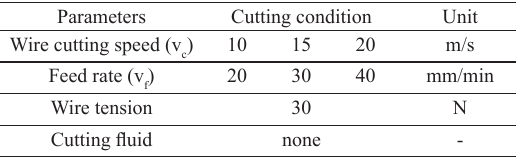
Figure 5. Kinematics of the cutting process. Table 1 – Cutting conditions applied in the experiments.